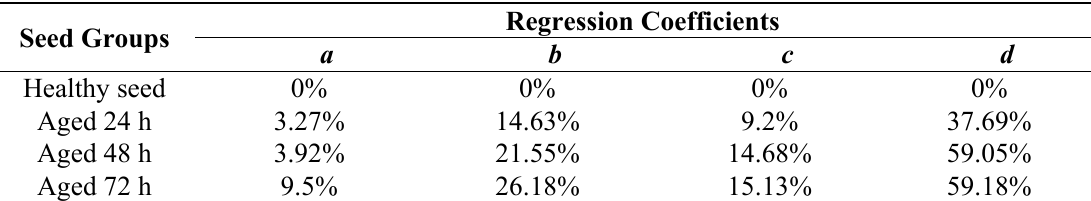
Table 2. Variation rate of regression coefficients of healthy seed and seeds aged for 24, 48, or 72 h.